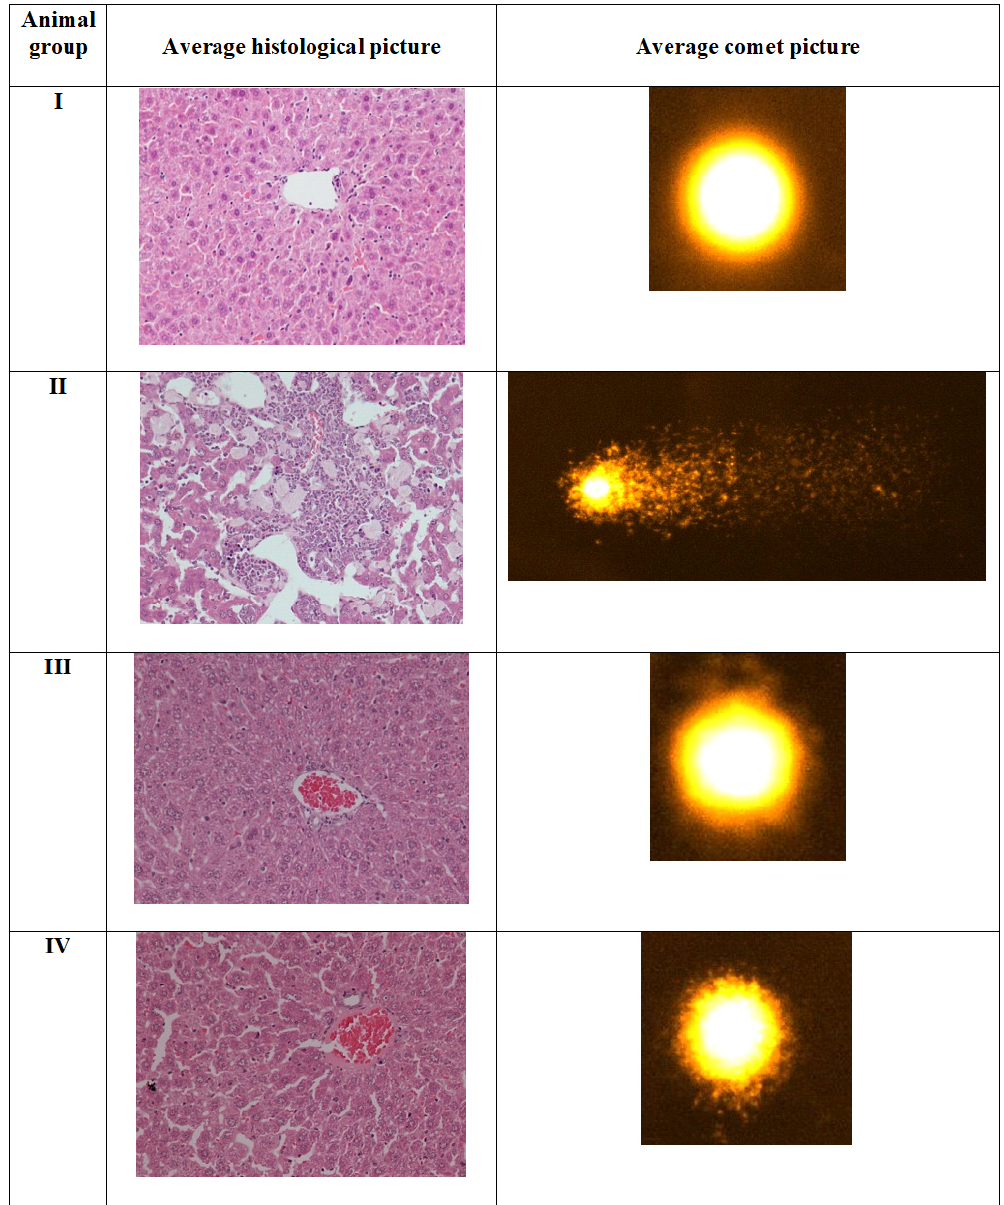
Figure 9. Average histological photomicrographs and Comet assay performed on the indicated groups. Group I shows the control without any treatment, while group II is control positive treated with CCl 4 . Group III and IV are complex 1 and 2 respectively.